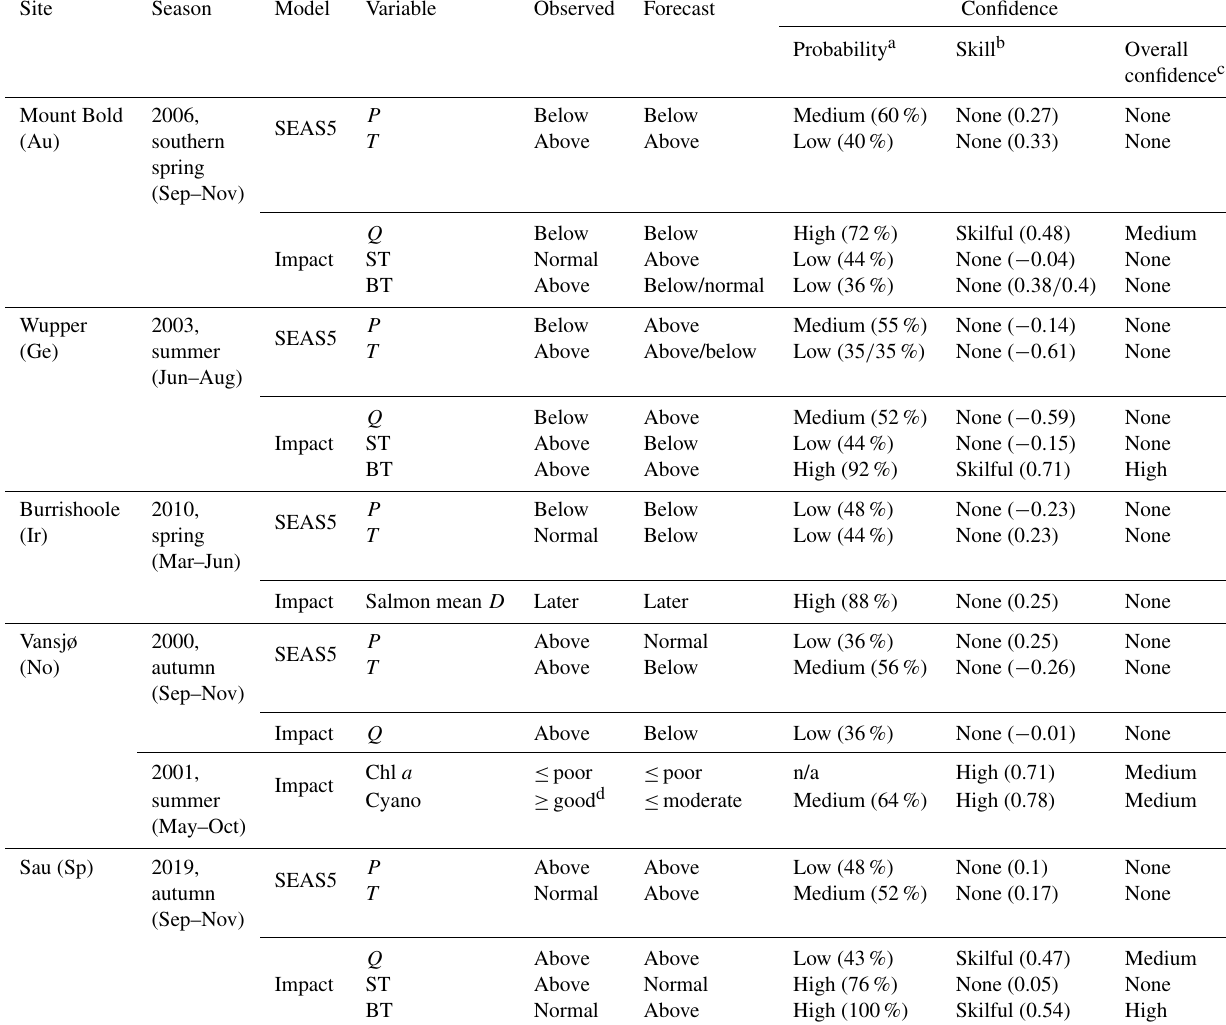
Table 3. Summary of forecasts for the historic events selected by water managers. Note: cyano – cyanobacteria; D – day of migration; BT – bottom water temperature; P – precipitation; Q – inflow discharge; ST – surface water temperature; T – air